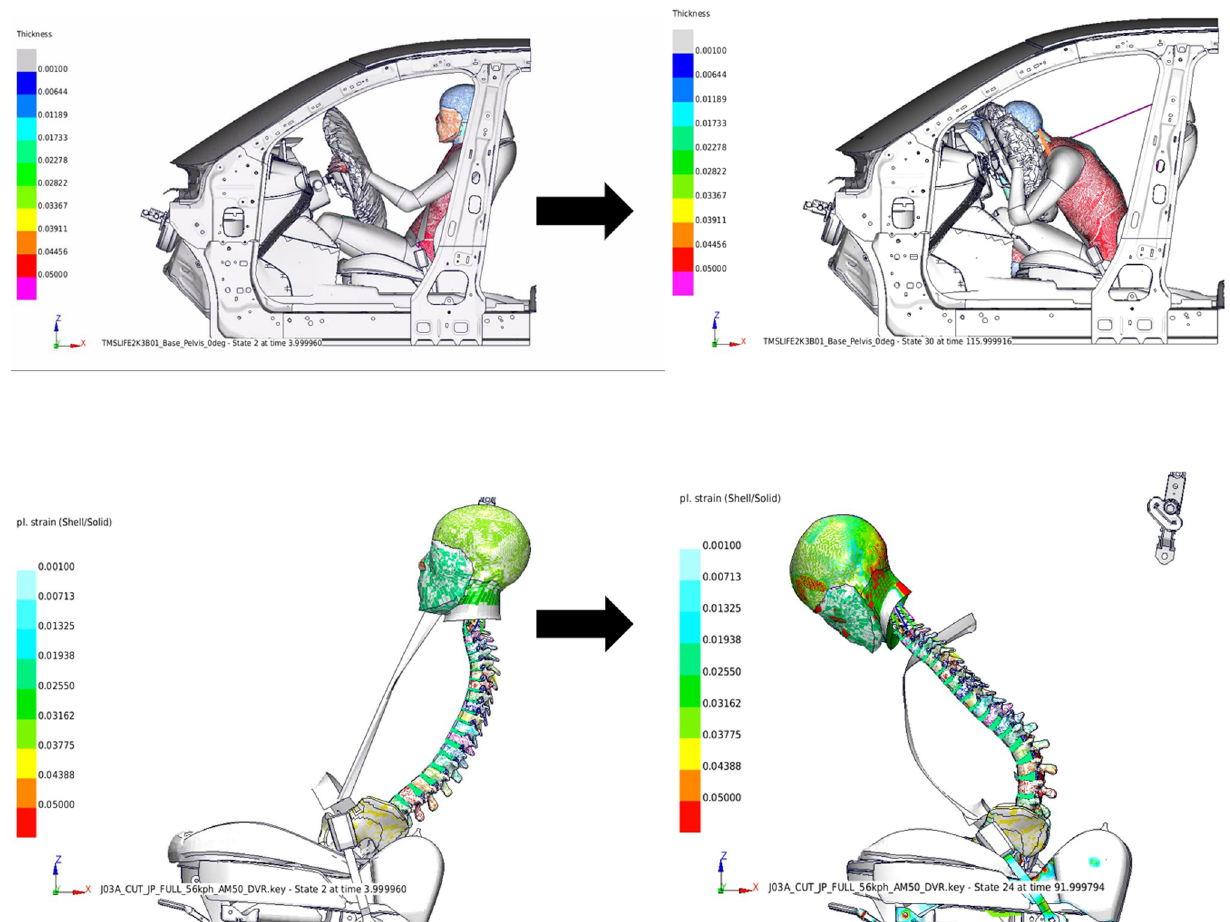
Fig 5. Initial position of the collision analysis. The upper two figures show the whole model and the lower figures shows only the spine and head. The left image shows the position before the experiment started and the right image shows the position after the collision. Overall, it shifted forward.